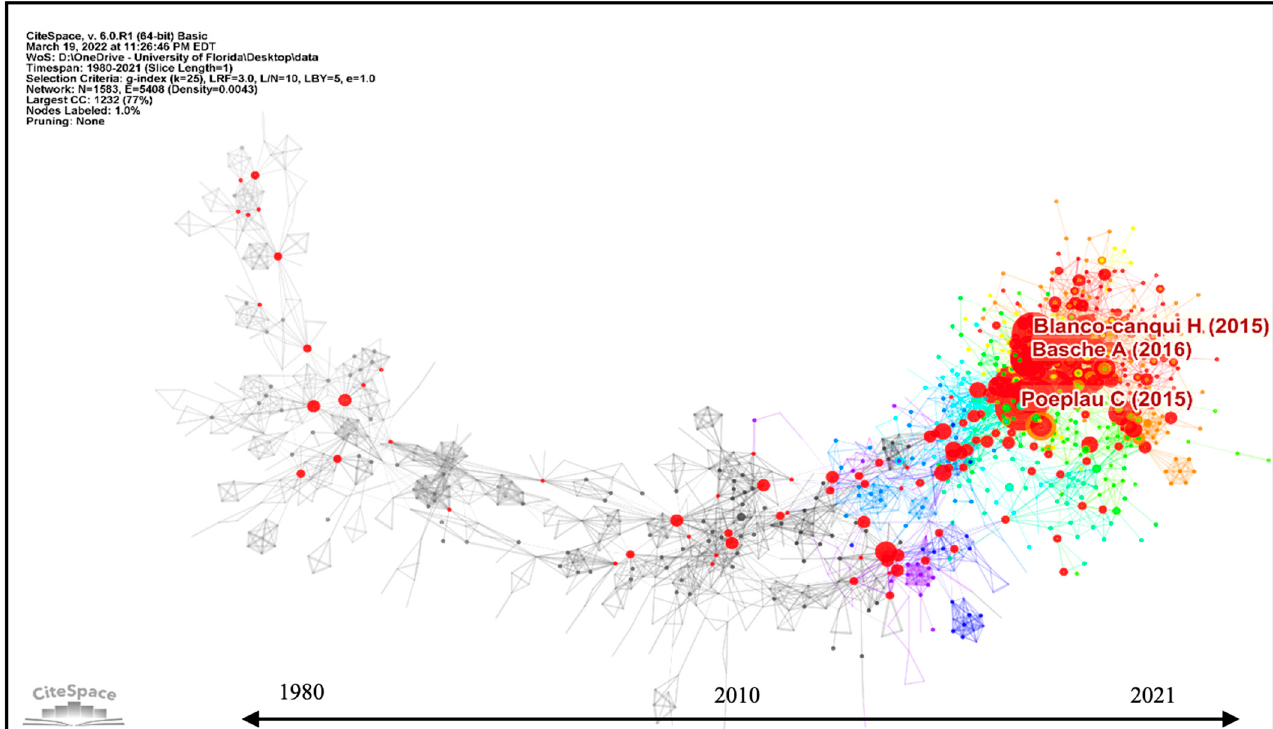
Figure 3. The overview of the co ‐ citation network.